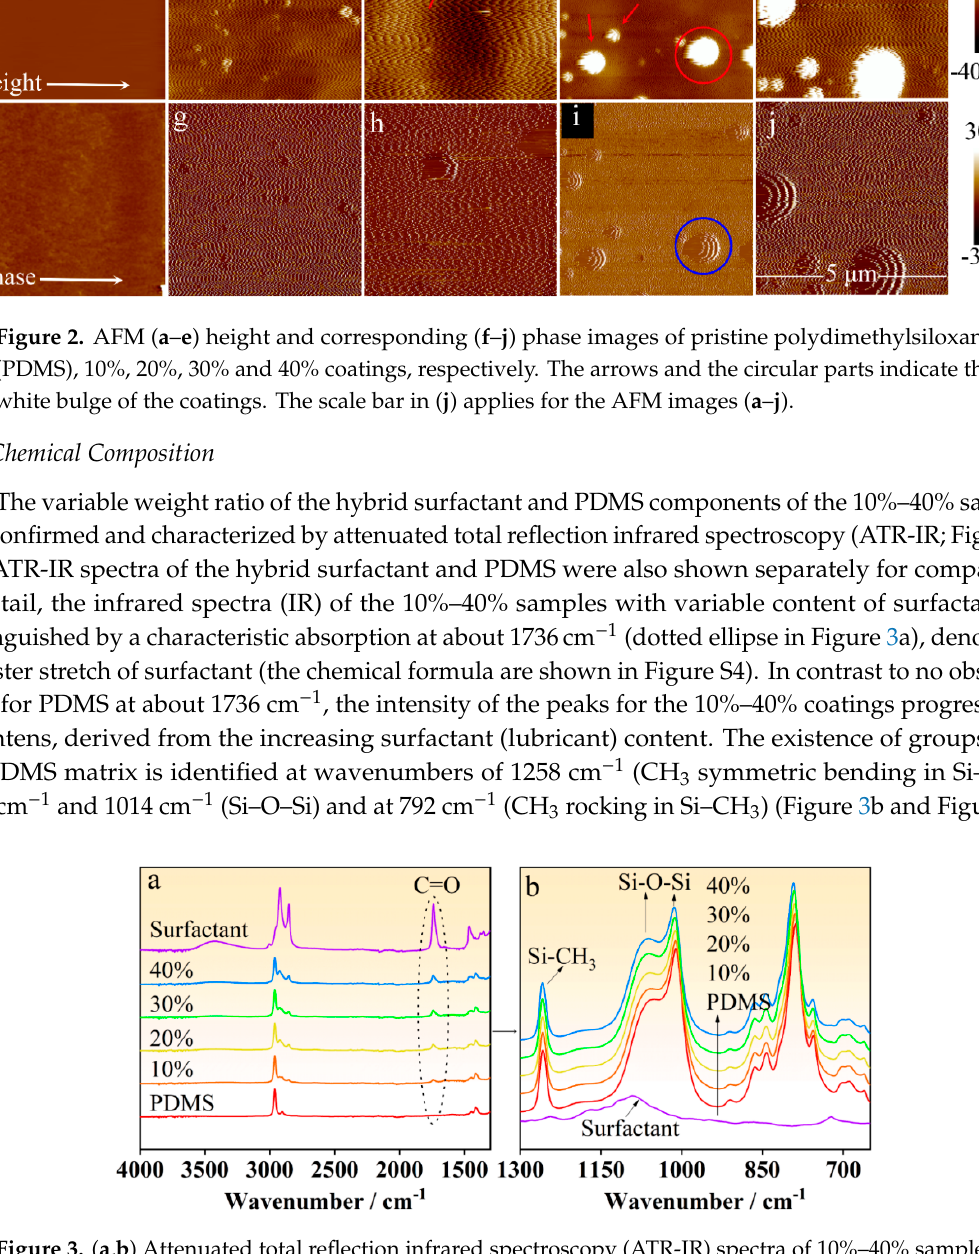
Figure 1. ( a , b ) Schematic of lubricant diffusing process. Top-view ( c ) and cross-sectional ( d ) SEM images of the 30% sample, respectively. Top-view ( e ) and cross-sectional ( f ) SEM images of the 30% sample after surfactant capsules being removed, respectively.